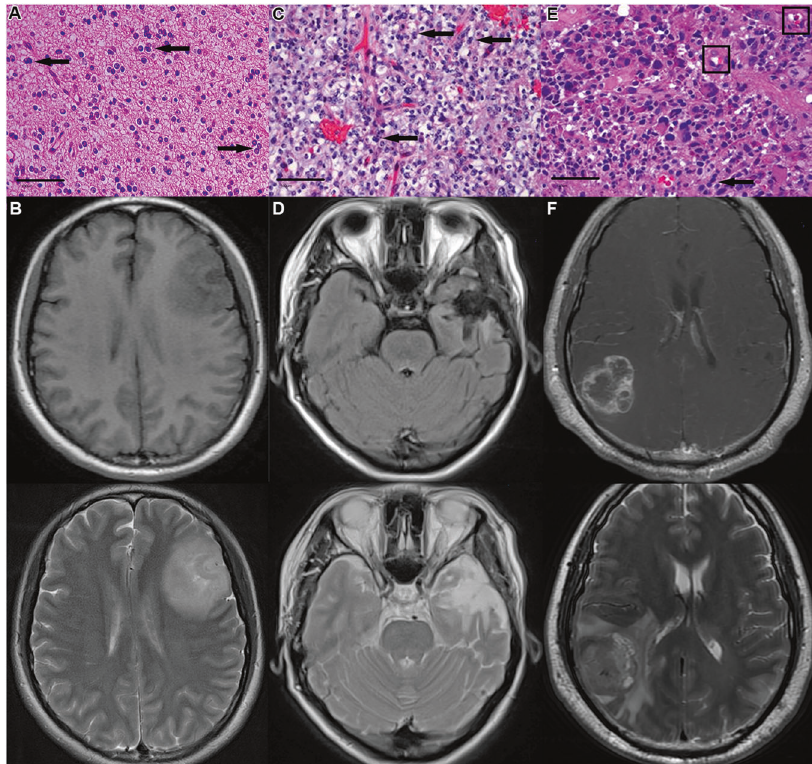
Fig. 1 Histology characteristics and MRI images of diffuse low-grade glioma and high-grade glioma. A Diffuse low-grade astrocytoma is composed of mutated astrocytes uniformly in fi ltrating around the brain tissues. The tumor cells show less nuclear atypia and slower proliferation. B The mass, in the temporal lobe, has isosignal and low intensity on T1-weighted imaging and shows mixed high and low signals on T2-weighted imaging. C Anaplastic astrocytomas show nuclear atypia and greater proliferative capacity, with nearby erythrocyte in fi ltration. D The occupied mass, in the temporal lobe, shows low intensity on T1-weighted imaging and high signals on T2-weighted imaging with irregular margins. E GBM shows apparent nuclear atypia and prodigious proliferation. F The tumor is located in the parietal lobe, with annular high intensity and central low intensity on T1-weighted imaging and mixed signals and peripheral edema signal on T2-weighted imaging. Tumor cell is dividing and duplicating their chromosomes (showing with arrows). Tumor cells masquerade as endothelial cells (showing in boxes). H&E, ×200, bar = 100 microns. GBM Glioblastoma multiforme.